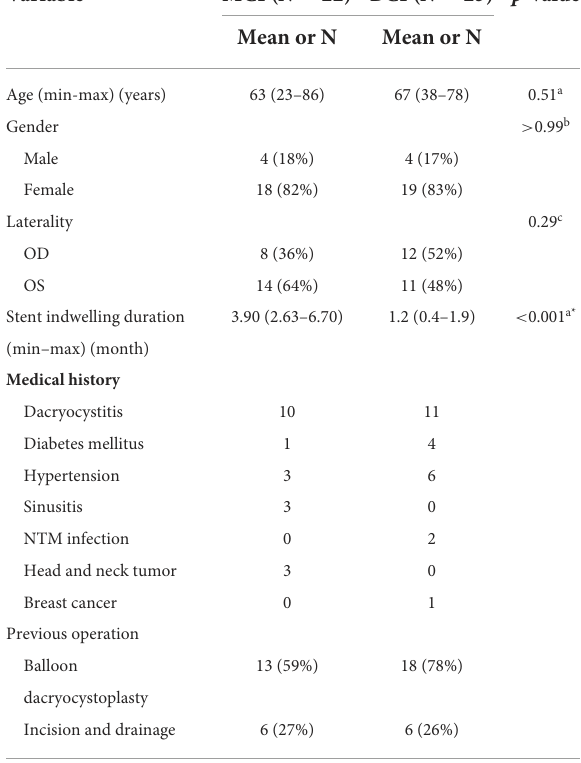
TABLE 1 Patient